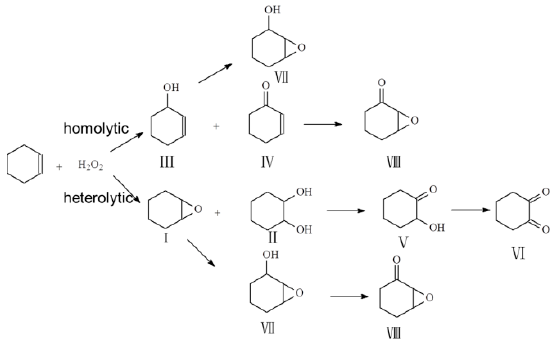
Table 2. Catalytic oxidation of cyclohexene over various Ti-CFI zeolites using H 2 O 2 aqueous solution as an